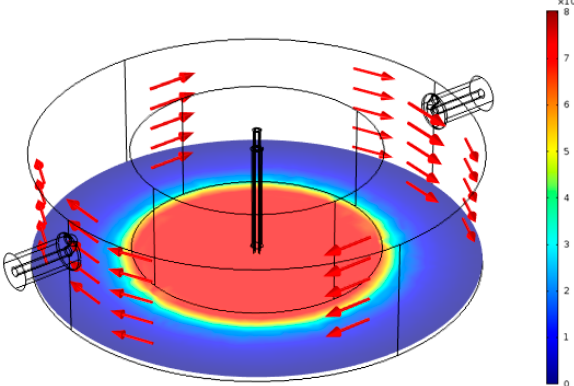
Figure 7. Simulation result for the normalized electric field (V/m) when the FEP sample tube is empty.